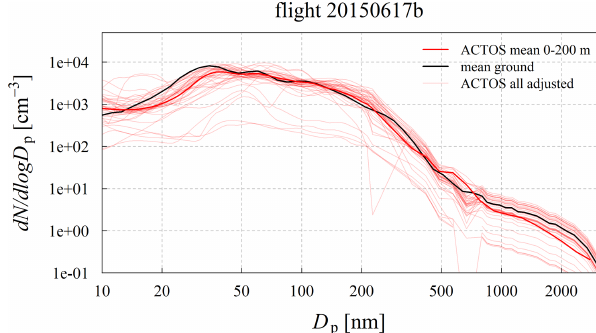
Figure 2. PNSD at the dried state derived during flight 20150617b. The red line indicates the mean PNSD in the atmospheric layer be- tween 0–200m sampled with the ACTOS MPSS and OPSS. The black line represents the mean PNSD derived on the ground dur- ing the ACTOS flight time. Red transparent thin lines display the PNSDs derived with ACTOS adjusted with the height-corrected PNSD measured at Melpitz